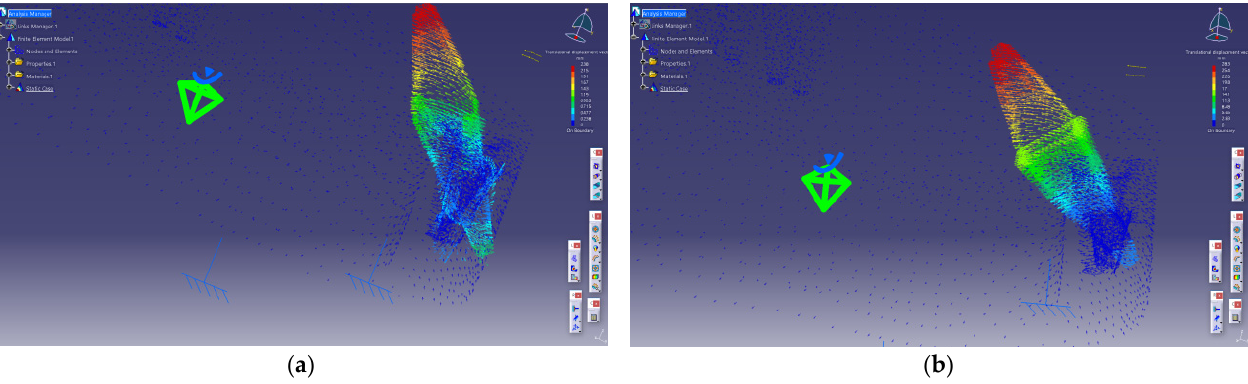
Figure 12. Lingualization of the LLI using a 3 N force: ( a ) tooth movement, 33% HBL; ( b ) tooth movement, 66% HBL.